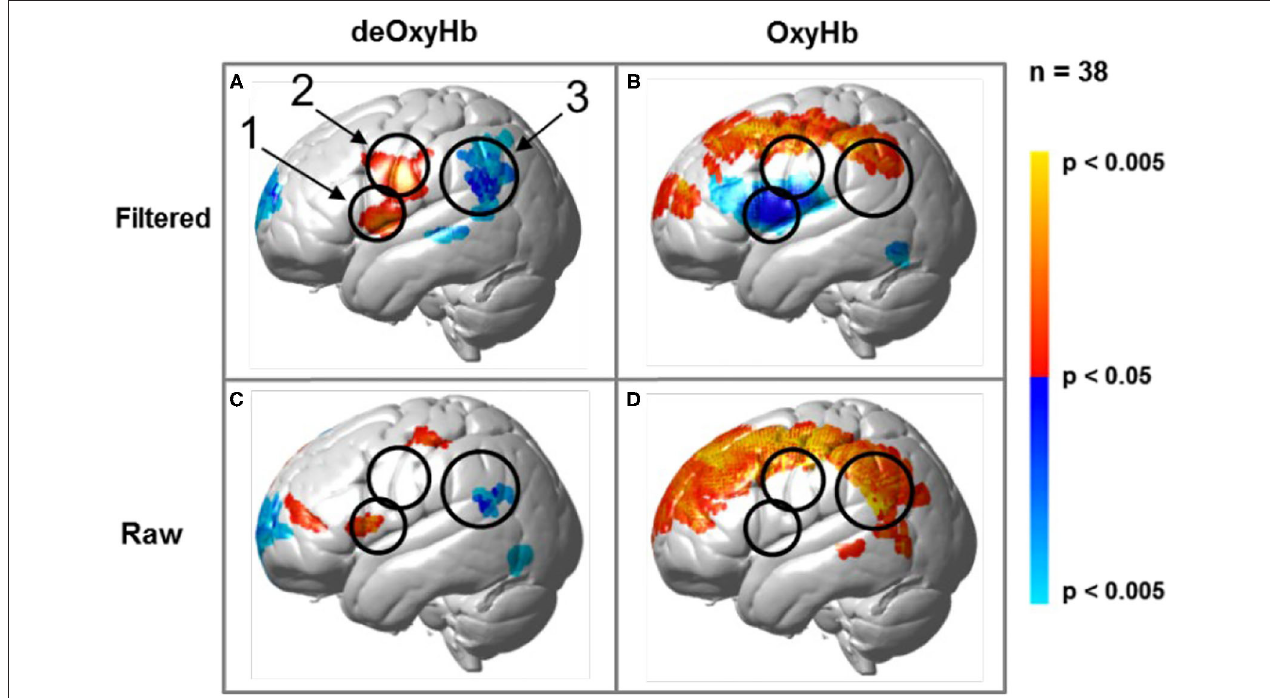
FIGURE 2 | Signal selection was based on empirical comparison of voxel-wise contrasts from deOxyHb (left column) and OxyHb (right column) signals with global mean removal (Filtered, top row) and without global mean removal (Raw, bottom row). Red/yellow indicates [talking > listening], and blue/cyan indicates [listening > talking] with levels of significance indicated by the color bar on the right. Images include left hemisphere sagittal views. The black circles represent the canonical language regions, Broca’s Area (anterior), the articulatory sensory-motor system (central), and Wernicke’s Area (posterior). The specific Regions of Interest (ROI) are indicated as 1, 2, and 3, respectively. See Table 1 . These regions are observed for the deOxyHb signals following global mean removal ( Zhang et al., 2016, 2017) shown in panel (A) , but not for the other signal processing approaches, as illustrated in panels (B–D) by the absence of expected localized activity. This empirical approach supports the decision to use the spatially filtered deOxyHb signal for this study and is consistent with similar findings of previous talking and listening experiments (Hirsch et al.,